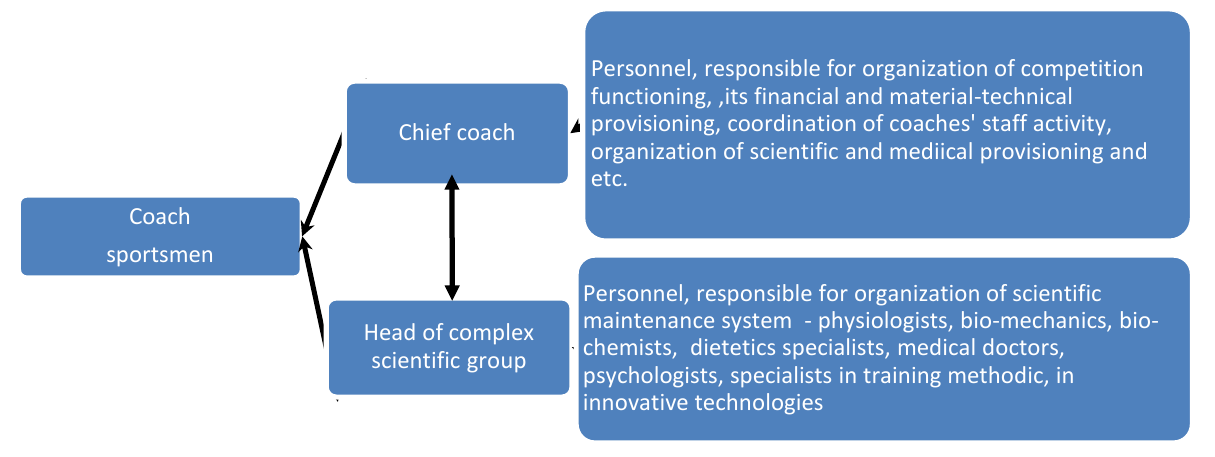
Fig. 4. Diagram of management of USSR and GDR combined teams in 1970-s